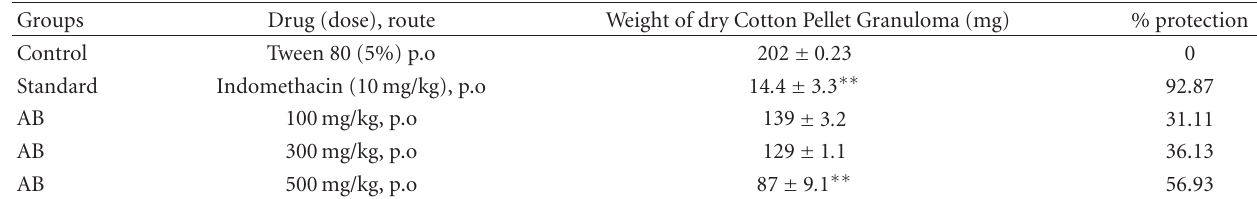
Table 2: Protective efeect of Pinus roxburghii Sarg. on cotton pellet induced granuloma.